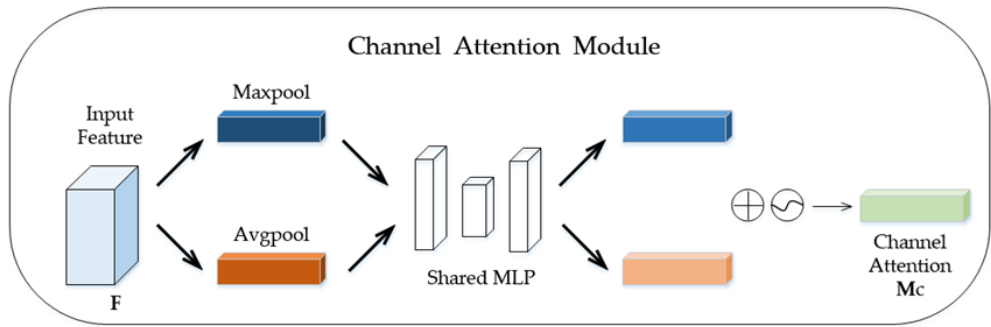
Figure 2. Channel attention module.